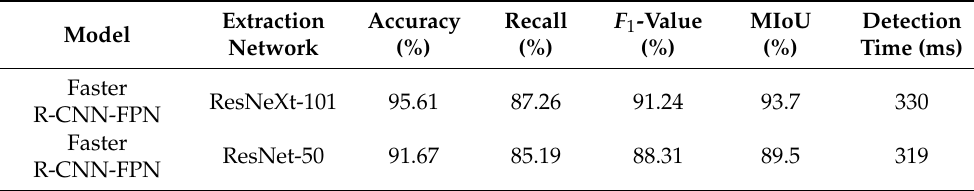
Figure 10. Overall loss comparison with the Faster R-CNN model. Table 2. Feature extraction network comparison.